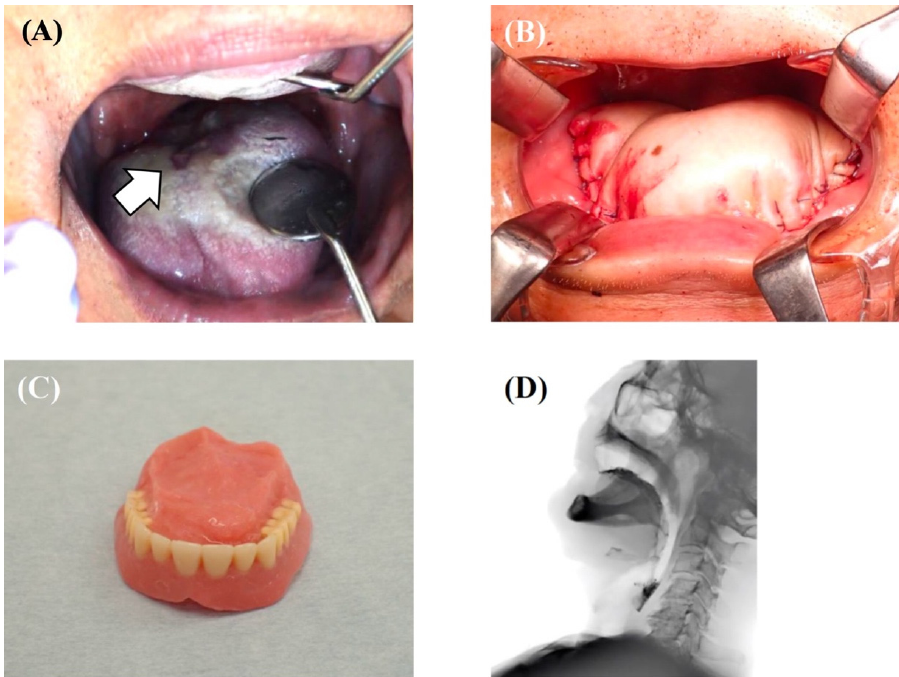
Figure 1. A case of tongue squamous cell carcinoma (T4aN3bM0, Stage IVB) treated with a tra- cheotomy, tumor resection, modified radical neck dissection (Type III), and pectoralis major muscu- locutaneous flap reconstruction; the patient recovered to be able to eat with palatal augmentation prosthesis. After completing chemoradiotherapy, the patient takes almost all of their nutrition orally and does well, with no recurrence or metastasis. ( A ) Mirror view of the primary tumor on the dorsum of the tongue. ( B ) Intraoperative photo of tongue reconstruction by pectoralis major musculocuta- neous flap. ( C ) Palatal augmentation prosthesis. ( D ) Findings of videofluoroscopic examination of swallowing where the patient was able to swallow jelly with palatal augmentation